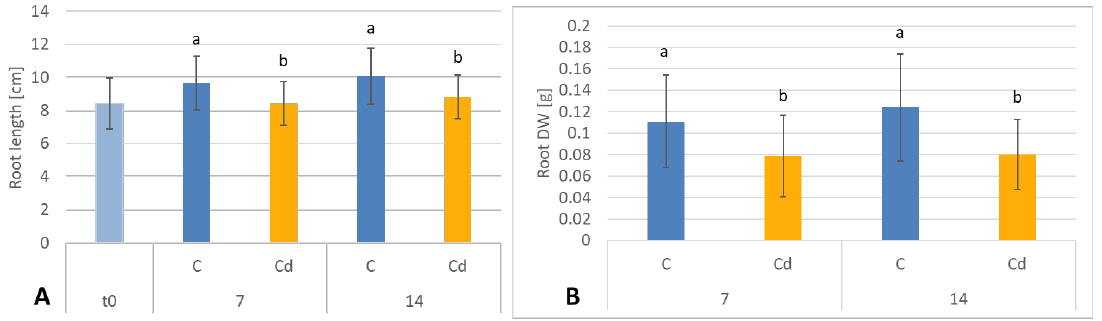
Figure 13. The length ( A ) and dry weight DW ( B ) of C. officinalis plant roots. t0 (light blue bar)- root length of three-week-old seedlings. Bars which do not share a common letter are significantly different ( p < 0.05).